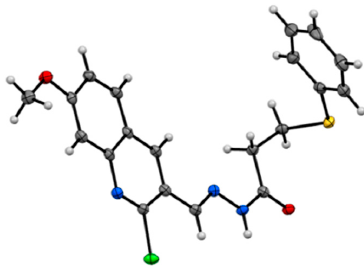
Figure 4. ORTEP diagram of X-ray crystal structure of 15 grown from chloroform.